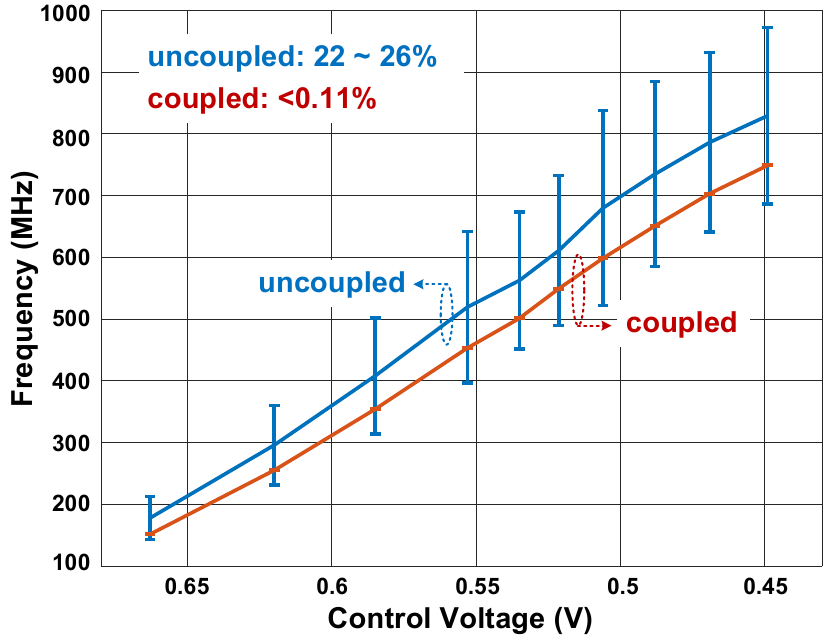
Figure 17. Frequency variation of coupled and uncoupled modes, for different average